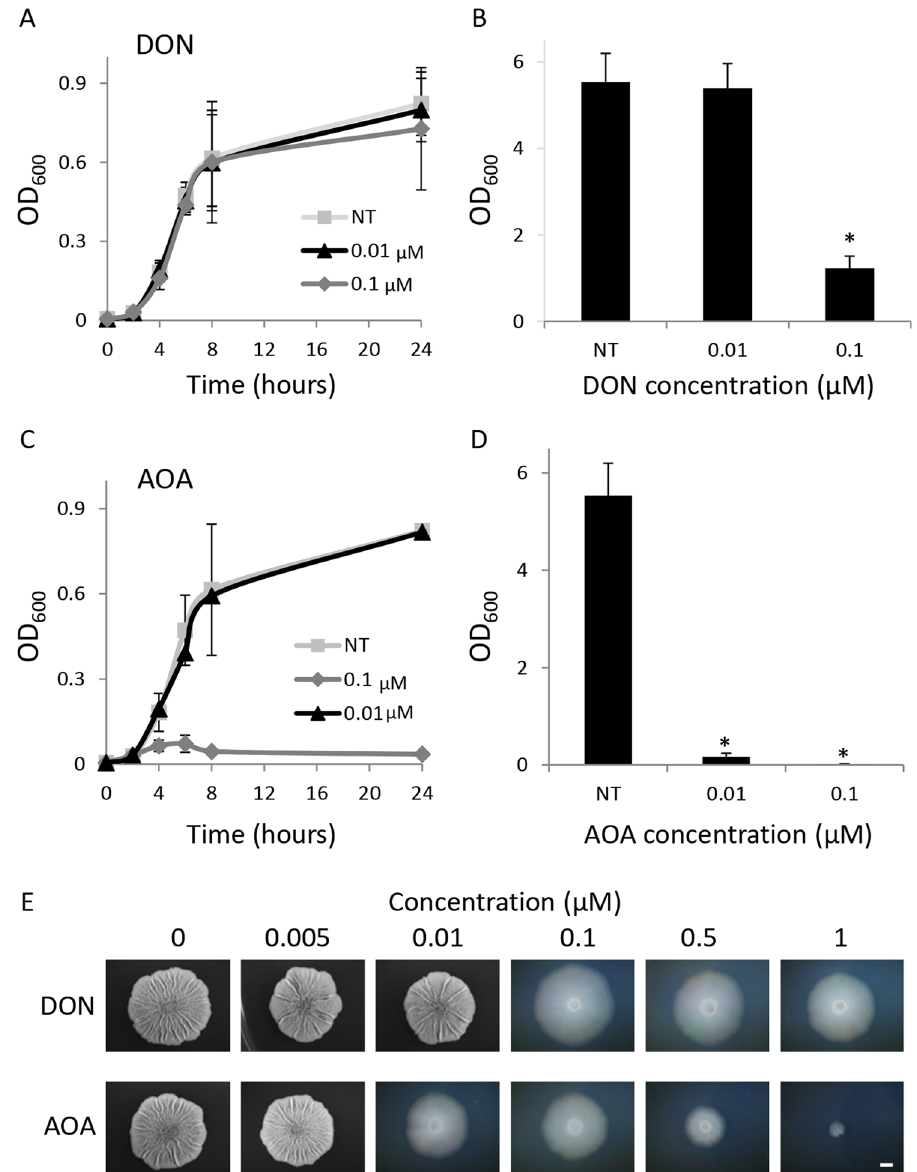
Figure 2. Targeting glutamate and glutamine synthesis inhibits biofilm formation. ( A ) Planktonic growth of bacteria grown in MSgg medium with or without different concentrations of DON ( µ m) was monitored by measuring OD 600 in a microplate reader. Results shown are averages of seven wells within one experiment and their corresponding standard deviations. A representative of six independent experiments is shown. ( B ) Biofilms were grown on solid MSgg medium in the presence of the indicated concentrations of DON ( µ M) for three days at 30 °C. After three days, cells were harvested, homogenized (see Materials and Methods) and cell density was determined by measuring OD 600 . Averages triplicates of one experiment are shown. Errors bars represent the corresponding standard deviations. This experiment is a representative of three independent experiments. ( C ) Planktonic growth of bacteria grown in MSgg medium with or without different concentrations of AOA ( µ M) was monitored by measuring OD 600 in a microplate reader. Results shown are averages of seven wells within one experiment. Errors bars represent the corresponding standard deviations. A representative of six independent experiments is shown. ( D ) Biofilms were grown on solid MSgg medium, in the presence of the indicated concentrations of AOA ( µ M) for three days at 30 °C. After 3 days, cells were harvested, homogenized (see Materials and Methods) and cell density was determined by measuring OD 600 . Averages of triplicates of one experiment are shown. Errors bars represent the corresponding standard deviations. The experiment is a representative of three independent experiments. ( E ) Biofilms were grown on solid MSgg medium for three days at 30 °C in absence or presence of the indicated concentrations of DON and AOA ( µ M). Images of biofilm colonies were acquired with a stereomicroscope (Zeiss). Scale bar corresponds to 2